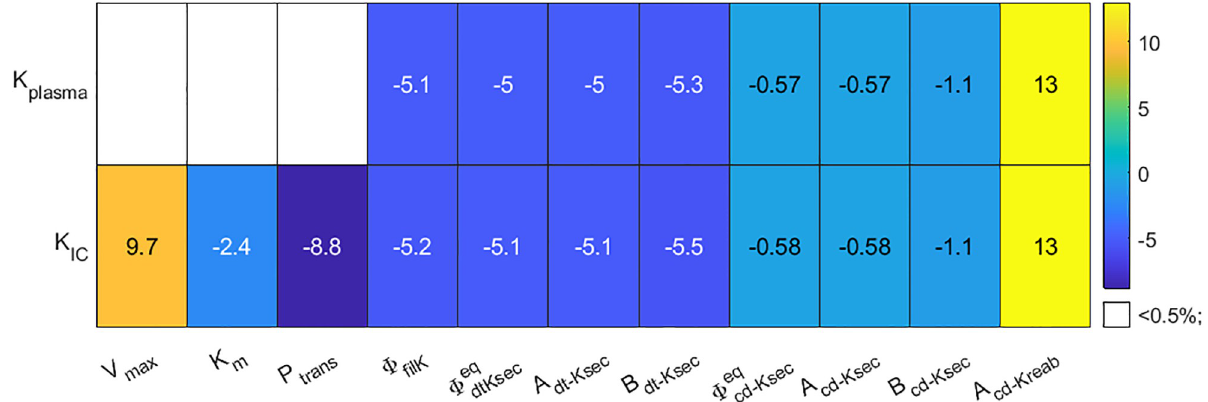
Fig 3. Local sensitivity analysis. Percent changes in baseline model steady state solution for plasma K + concentration (K plasma ) and intracellular K + concentration (K IC ) in response to a perturbation of 10% increase of the given parameter